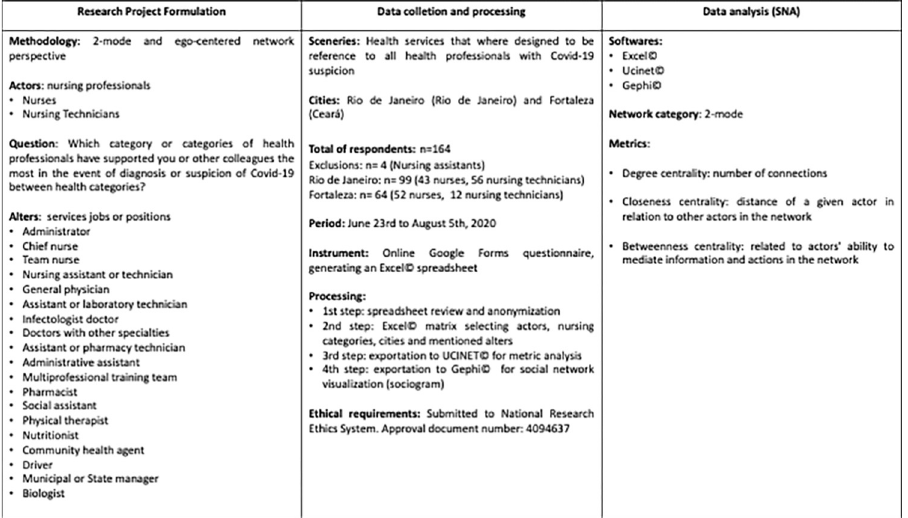
Fig 1. Research design and development